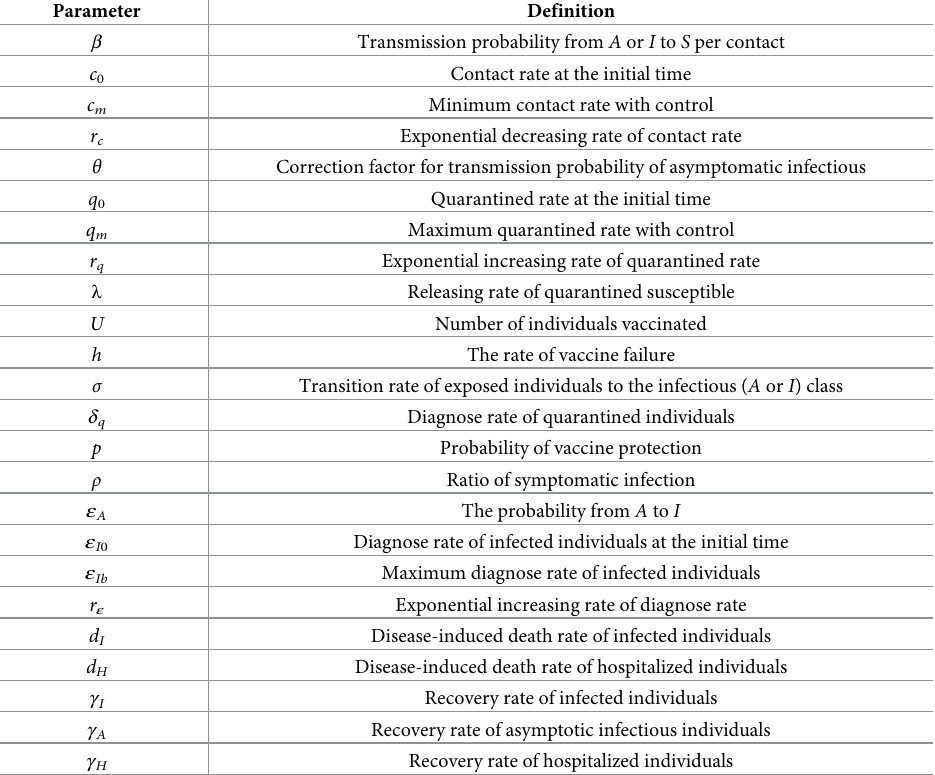
Table 3. Definition of